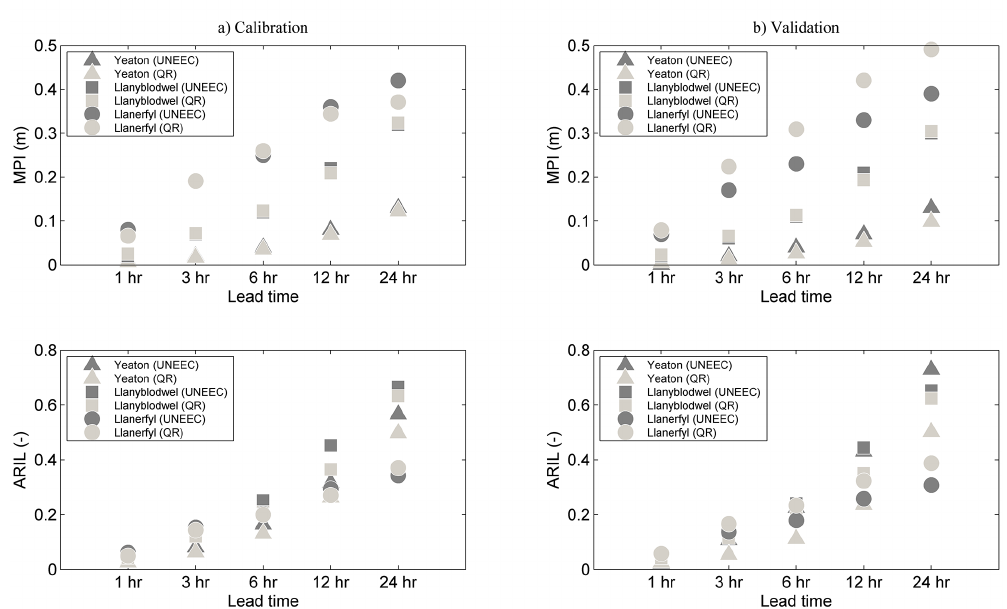
Figure 13. MPI (left) and ARIL (right) values obtained during calibration period (7 March 2007, 08:00UTC–7 March 2010, 08:00UTC) and validation period (7 March 2010, 20:00UTC–7 March 2013, 08:00UTC) for the 90% confidence